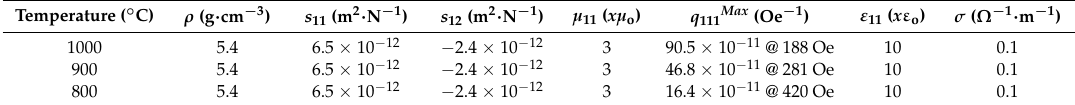
Table 1. Material coefficients for NiFe 2 O 4 spark plasma sintered at decreasing temperatures: density ρ , elastic compliances s ij , magnetic permeability µ 11 , maximum piezomagnetic coefficient q 111 Max (the magnetization field for maximum response is also indicated), dielectric permittivity ε 11 and conductivity σ .